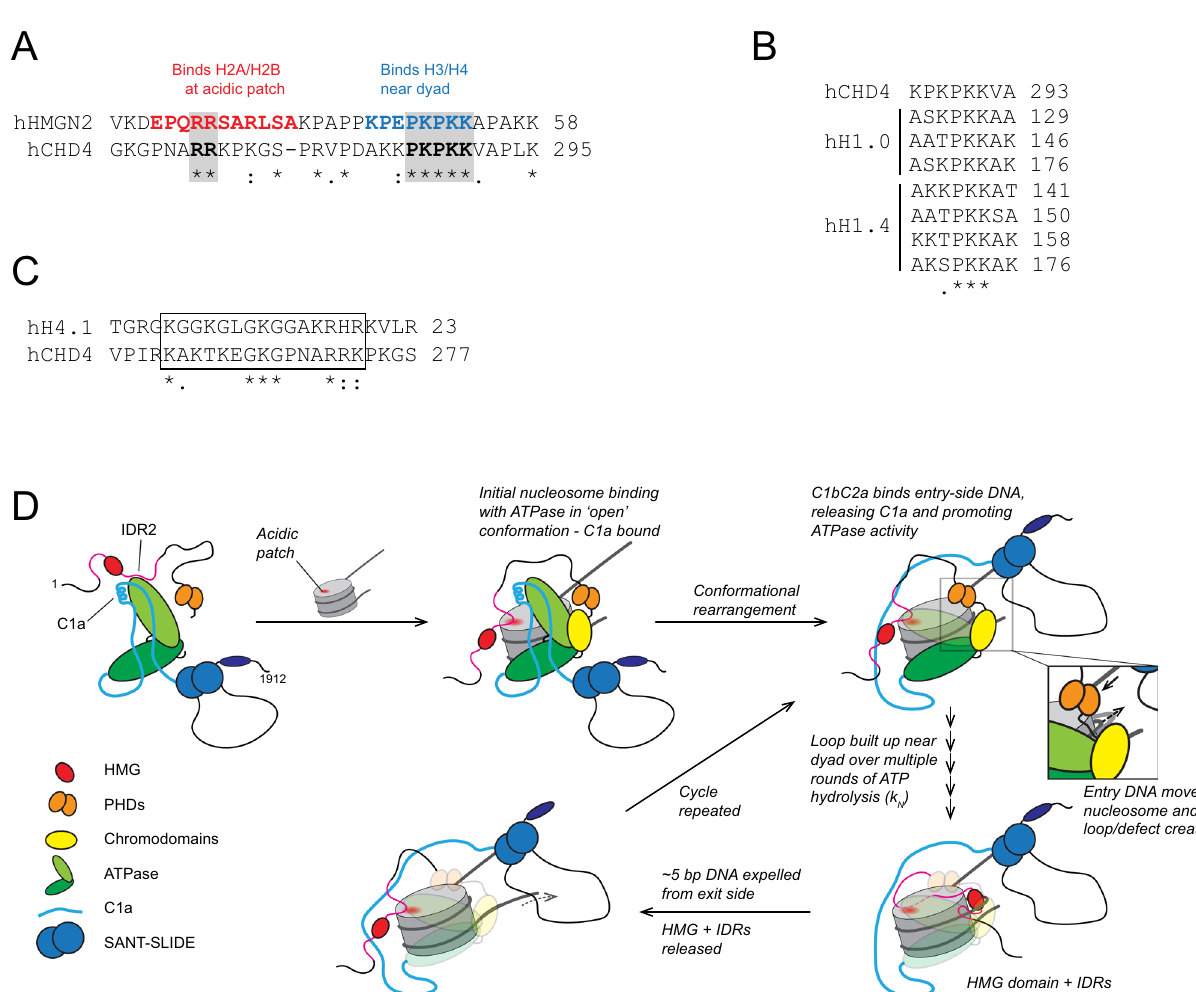
Fig. 8 | Updated model for nucleosome remodelling by CHD4. A Alignment of part of the nucleosome binding region of human HMGN2 (Uniprot: P05204) with the IDR of CHD4. B Alignment of a portion of CHD4 IDR2 with C-terminal repeats from the human linker histone H1 orthologues H1.0 (Uniprot: P07305) and H1.4 (Uniprot: P10412). C Alignment of the N-terminal tail of human histone H4.1 (Uni- prot: P62805) with a portion of CHD4 IDR2. D Model for the mechanism of nucleosome remodelling by CHD4. Domains are coloured according to Fig.